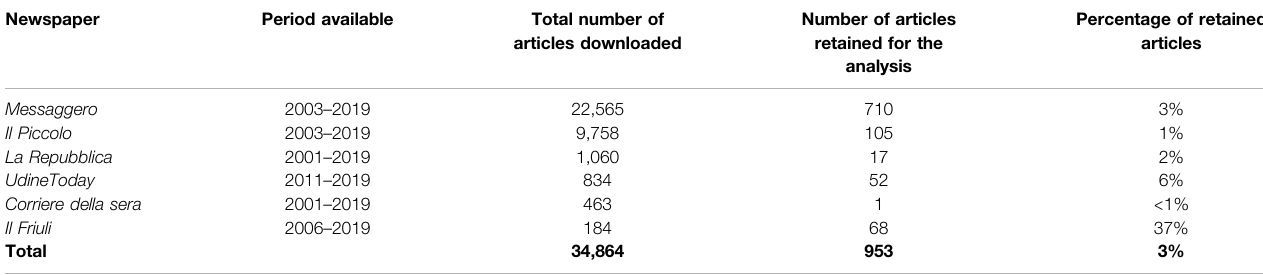
TABLE 1| Newspaper search results at the time of theanalysis(December 06, 2019), includingthe newspapername, period oftime available fordownload, total number of articles downloaded, number of articles retained for the analysis after fi ltering, and percentage of articles retained for the analysis (i.e., percentage of articles retained out of the total number of articles). The total as sum of the articles downloaded and retained for all the newspapers is also